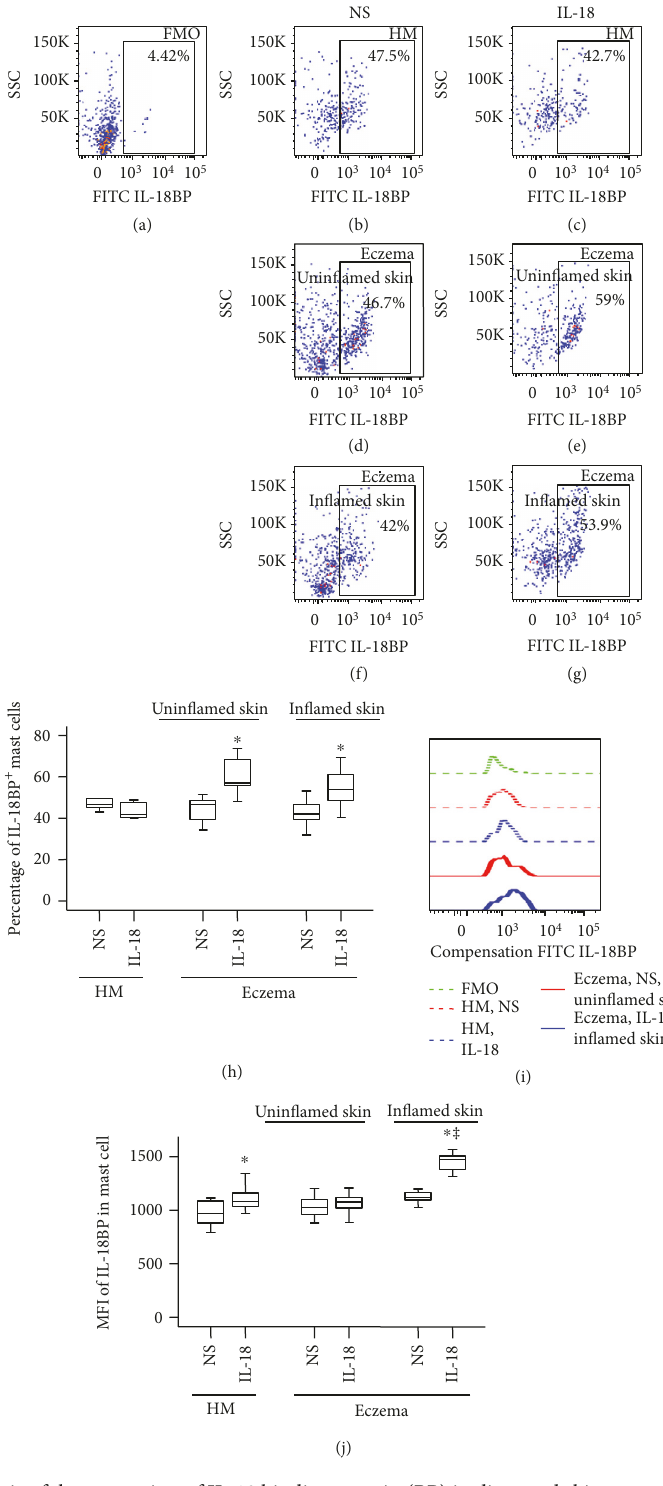
Figure 4: Flow cytometry analysis of the expression of IL-18 binding protein (BP) in dispersed skin mast cells of mice. (a) FMO for IL-18BP; (b), (d), and (f) show percentage of IL-18BP+ mast cells in skin of healthy mice (HM) and in normal or in fl ammatory skin of eczema mice treated with normal saline (NS), respectively. (c), (e), and (g) show percentage of IL-18BP+ mast cells in skin of healthy mice (HM) and in normal or in fl ammatory skin of eczema mice treated with IL-18, respectively. (h) represents median percentage values of mast cells in mouse skin. (i) shows representative fl ow cytometric fi gures of mean fl uorescence intensity (MFI) of IL-18BP+ mast cell. (j) demonstrates changes in MFI of IL-18BP+ mast cell. Data shown are the median (range) value from 6 di ff erent mice. ∗ P < 0 05 in comparison with NS group (paired Mann – Whitney U test). ‡ P < 0 05 compared with HM NS